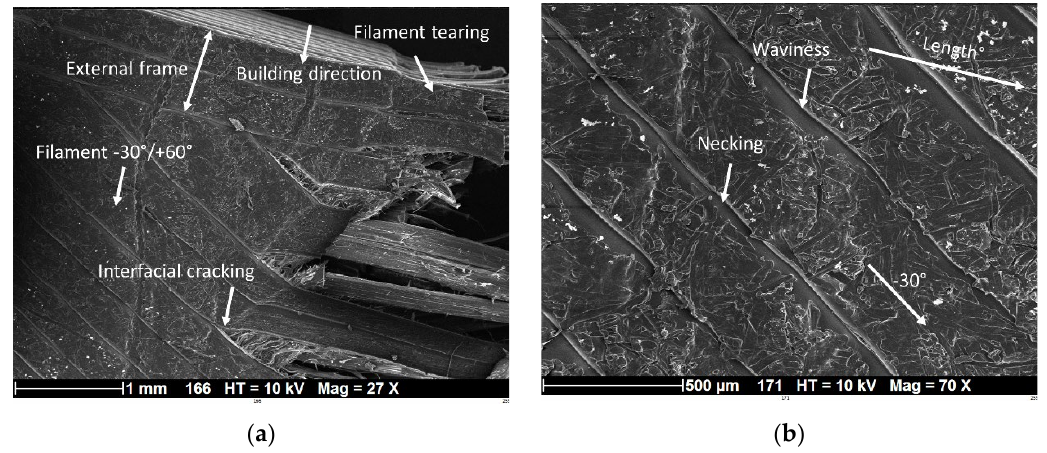
Figure 14. SEM micrographs of fractured surface of 3D-printed PLC according to horizontal orienta- tion (LO) (printing angle θ = 15 ◦ ): ( a ) close-up view on the fracture area, and ( b ) zoomed-in view of the